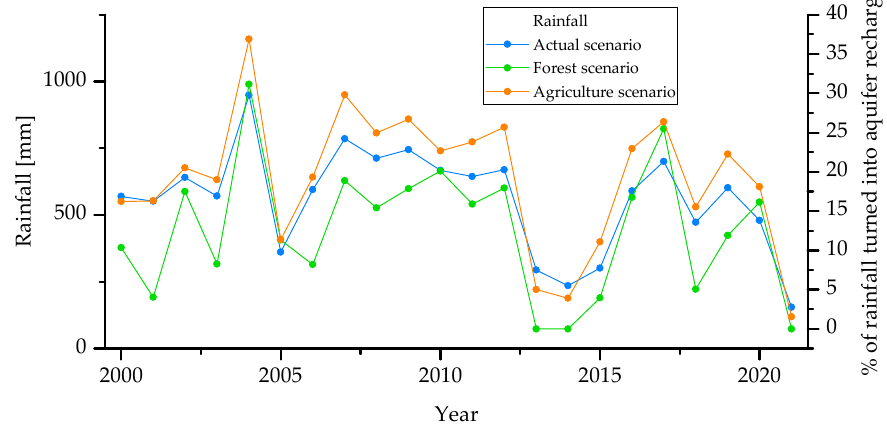
Figure 5. Annual discretization of rainfall and percentage of rainfall turned into aquifer recharge, for each land cover scenario from 2000 to 2021.